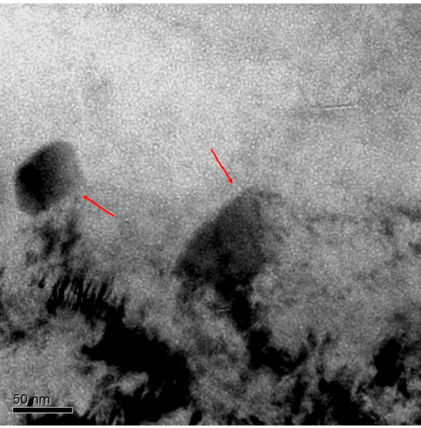
Figure 6. TEM micrograph of EUROFER97 steel annealed at 450 °C for 100 h showing the distribution of bubbles within the matrix in zone B of intermediate He concentration (619 to 548 appm). The arrows indicate bubble nucleation at the M 23 C 6 matrix interface.